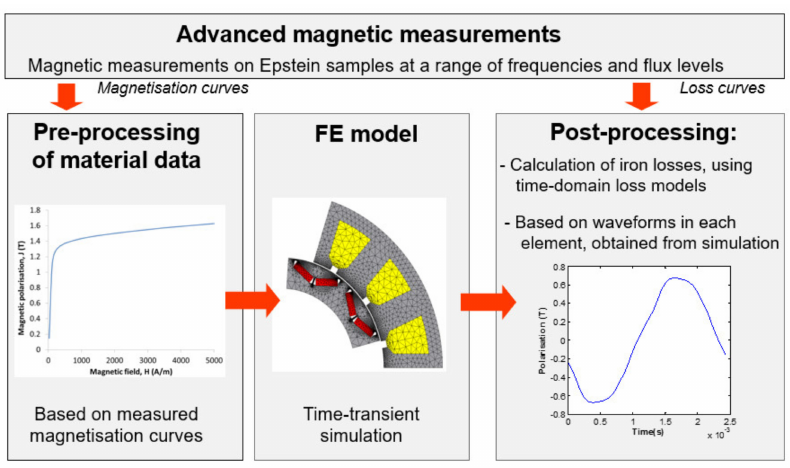
Figure 5. Overview of the ArcelorMittal core loss modelling